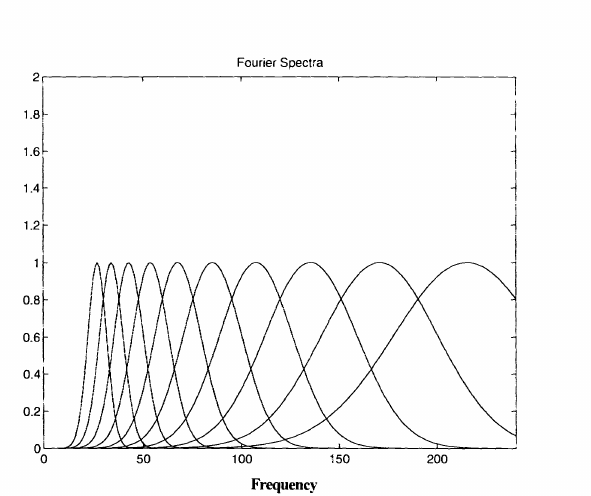
FIGURE 2 Frequency width of wavelets expands with scale